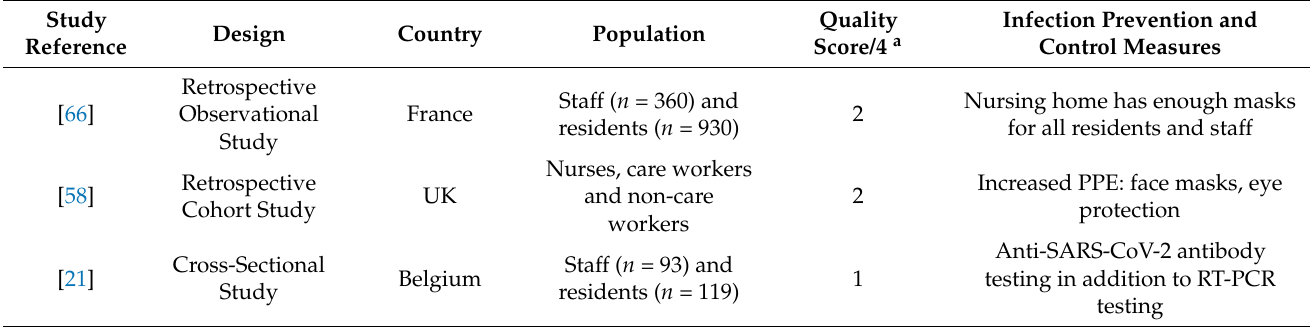
Table 2. Study characteristics and COVID-19 IPC measures implemented in nursing home